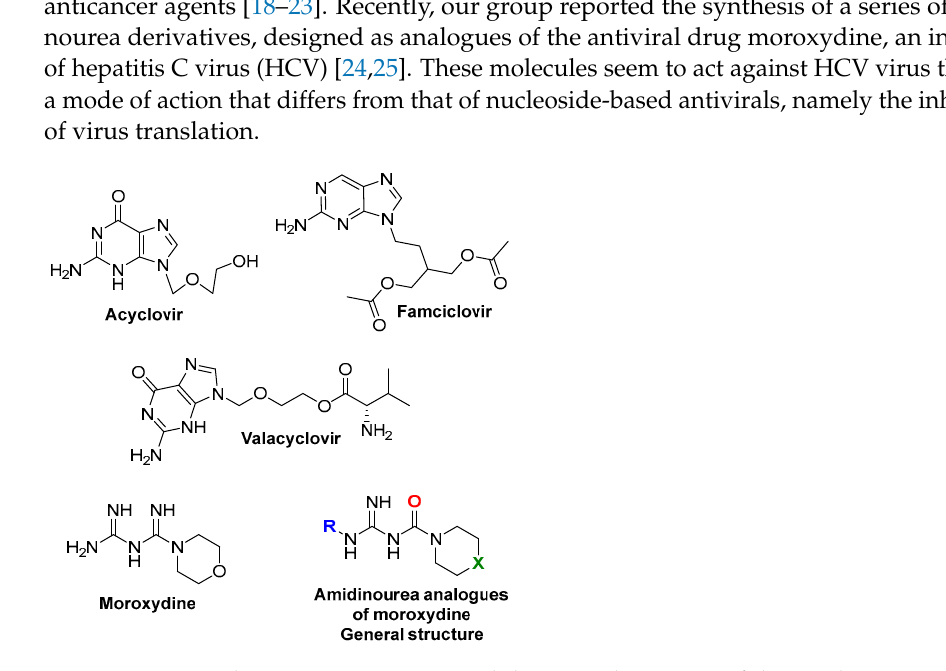
Figure 1. Antivirals active against HSV and the general structure of the amidinourea antivirals discussed in this work.